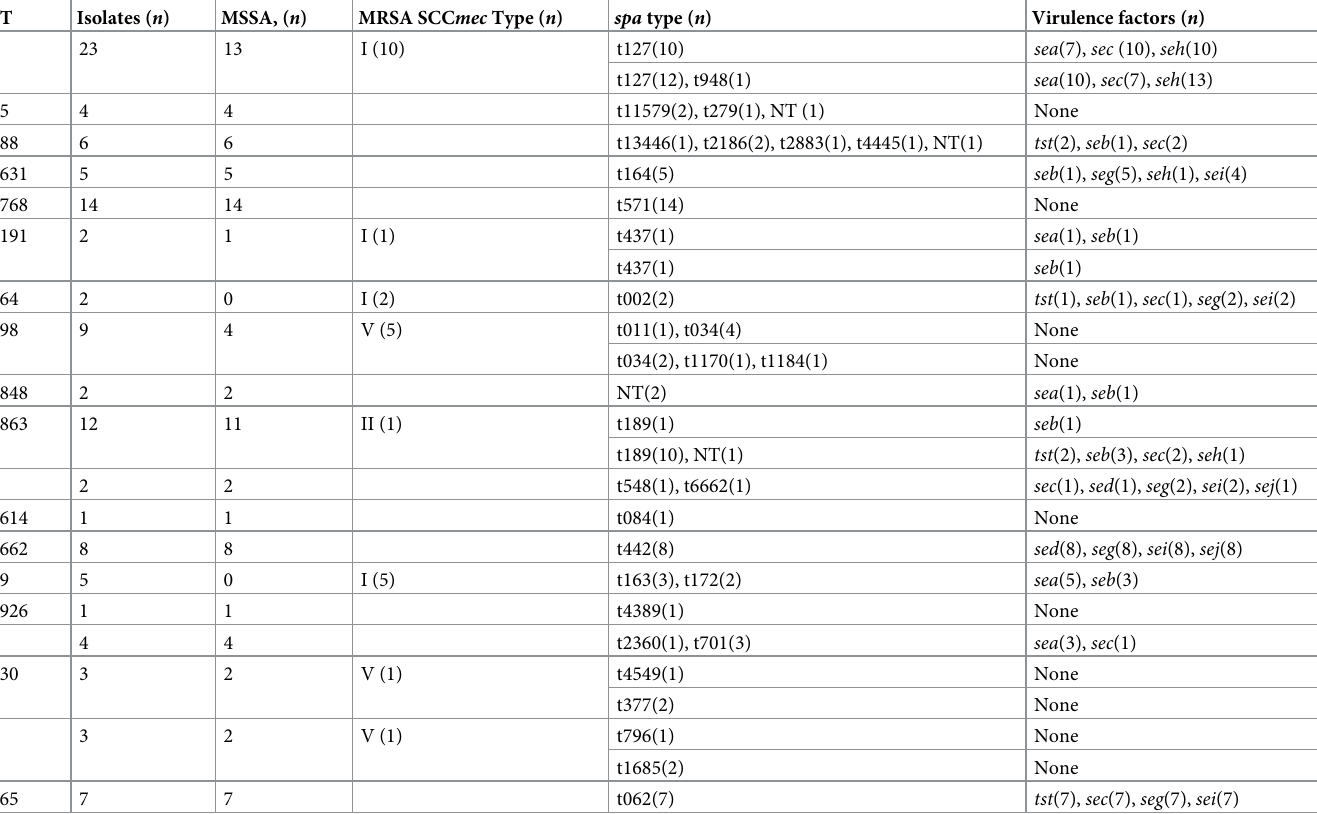
ST, sequence type by multi-locus sequence typing; SCC mec , Staphylococcal cassette chromosome mec ; spa , Staphylococcus protein A gene; NT, not-typeable; None, no virulence gene detected.